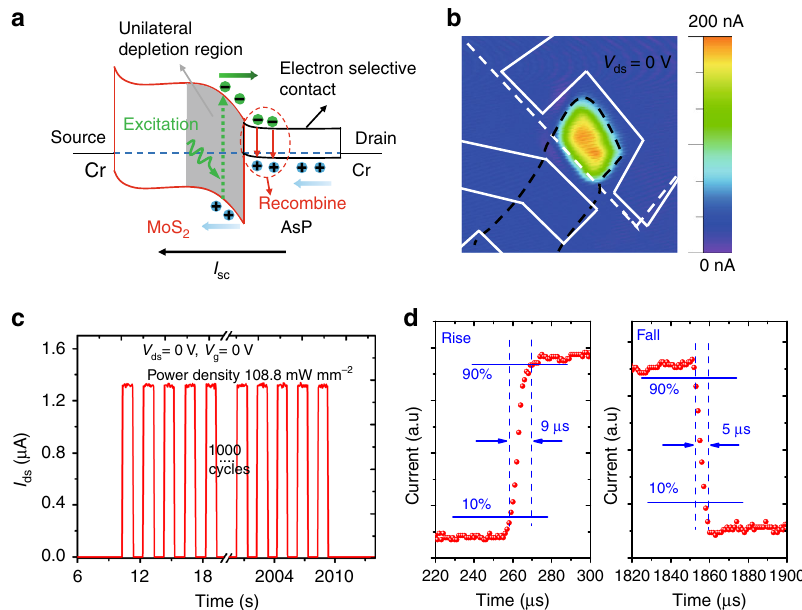
Fig. 5 Photocurrent mapping and response time measurement of the MoS 2 /AsP vdWHs diode. a Energy band diagram of the MoS 2 /AsP vdWHs diode under 520nm laser illumination at zero bias. b Scanning photocurrent mapping of the MoS 2 /AsP vdWHs diode under 520 nm laser illumination with the laser spot size less than 1 μ m at V ds = 0 V. c Photoswitching response of the MoS 2 /AsP vdWHs diode at V ds = 0 V. d Time-resolved photoresponse of the MoS 2 /AsP vdWHs diode at V ds = 0 V